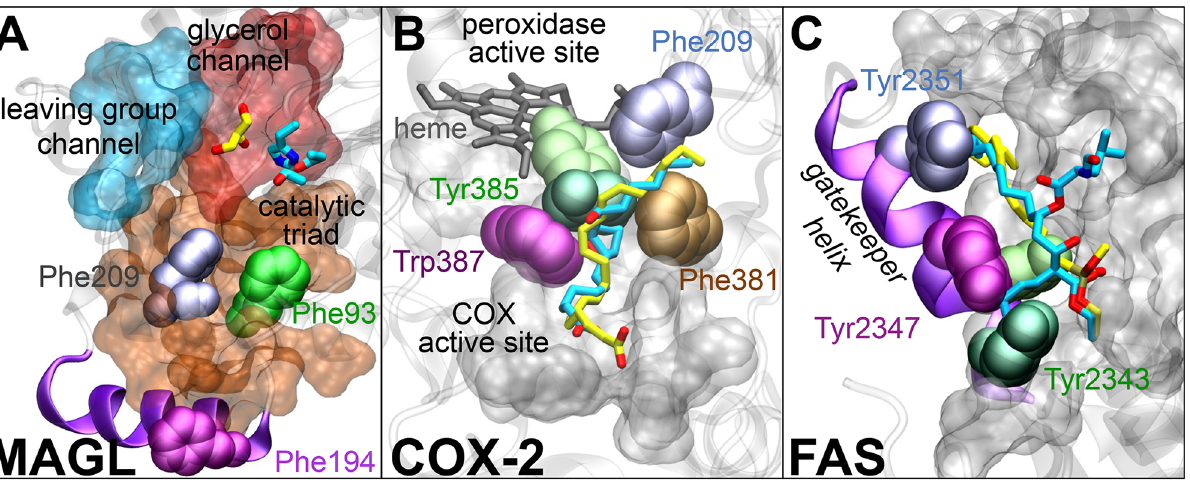
Fig 7. (A) Active site of the apo form of monoacylglycerol lipase (MAGL – 3HJU.pdb).[4] A long acyl-chain channel (orange) is supposed to accommodate the arachidonoyl chain of 2-arachidonoylglycerol (2-AG), thanks to the presence of the aromatic Phe93 (green) and Phe209 (magenta). At the top of the active site, a polar cavity (red) likely accommodates the glycerol head group of 2-AG, as a glycerol molecule (yellow sticks) has been crystallized in this region. A third cavity (cyan) is thought to allow the exit of the substrate leaving group, after hydrolysis. The Ser122 – Asp239 – His269 catalytic triad is also shown with cyan sticks. (B) Superimposition of the cyclooxygenase COX-2 in complex with the arachidonic acid substrate (yellow — 1DIJ.pdb) and with the prostaglandin H 2 (PGH 2 ) product (cyan — 1DDX.pdb).[71] The catalytic Tyr385 is in dark green when in the presence of arachidonic acid and light green when in the presence of PGH 2 . It shows a conformational change that opens the gate from the cyclooxygenase to the peroxidase active site. For clarity, the key Trp387 (magenta), Phe381 (maroon), and Phe209 (ice blue) are only shown for the 1DIY.pdb. The heme co-factor is also shown. The cyclooxygenase and peroxidase active sites are in gray molecular surface. (C) Active site of the human fatty acid synthase (FAS) covalently bound to the methyl γ - linolenylphosphonate substrate (yellow — 3TJM.pdb)[75] and to the antitumor drug Orlistat (cyan — 2PX6.pdb).[76] In the presence of the γ -linolenyl chain, Tyr2343 (light green) forms a “ gatekeeper helix ” with Tyr2351 (magenta) and Tyr2347 (sky blue), leading to the formation of a long groove tunnel for the selective binding of the linolenyl chain. When bound to Orlistat, Tyr2351 (dark green) is buried within the active site, causing the loss of the “ gatekeeper helix ” mechanism, which is not formed. Tyr2351 (magenta) and Tyr2347 (ice blue), as well as the “ gatekeeper helix ” (violet ribbons), are only shown for the 3YJM. pdb. The protein active site is in gray molecular